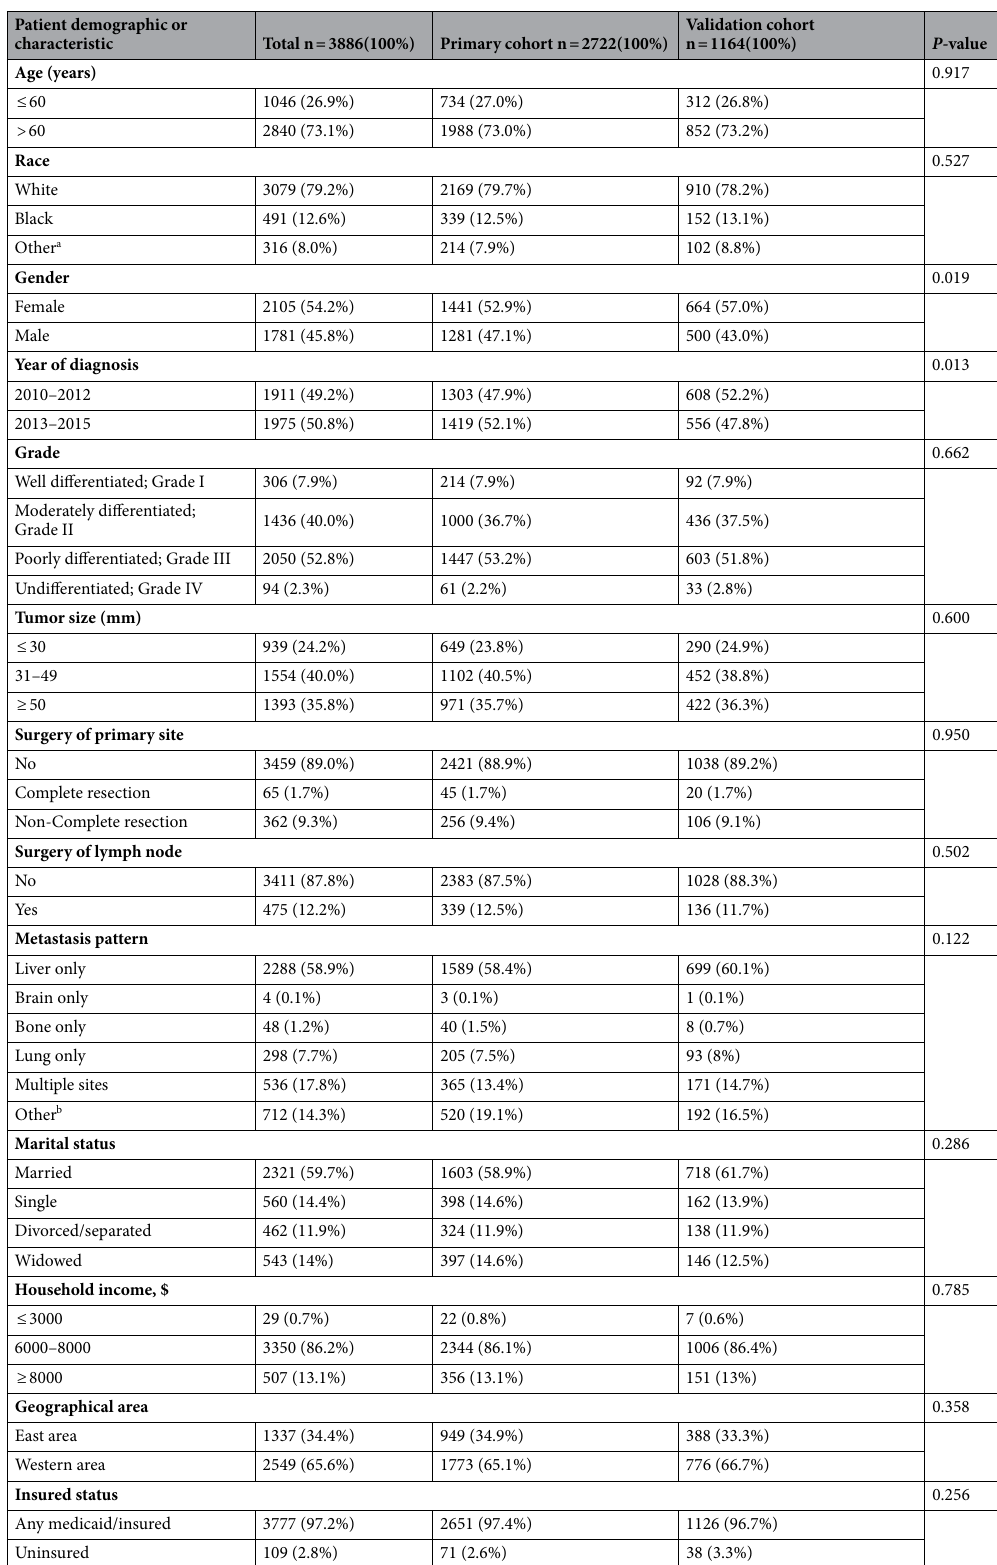
Table 1. Summary of the demographics and clinic-pathologic characteristics of the patients in the study. a American Indian/AK Native, Asian/Pacific Islander; b Para-aortic lymph nodes, duodenum lymph nodes, peripancreatic lymph nodes,